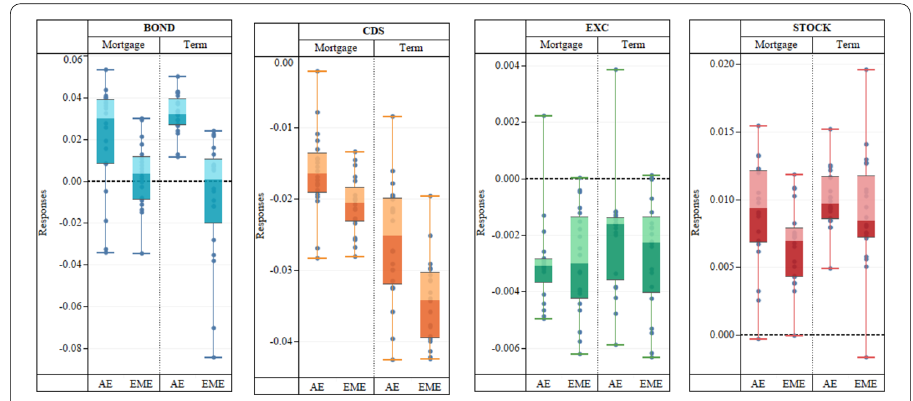
Fig. 10 Distribution of immediate responses to US mortgage and term spread shocks: Cross-country differentiations within EMEs and